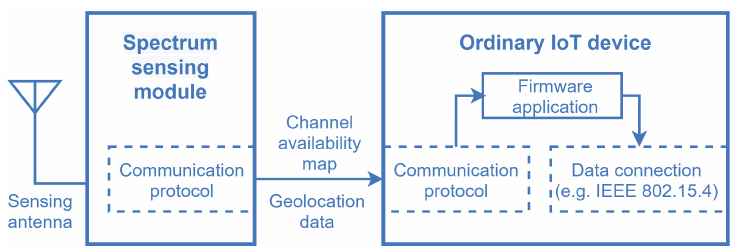
Figure 6. Model of an SSIoT device formed by the connection of an ordinary IoT device and an spectrum sensing